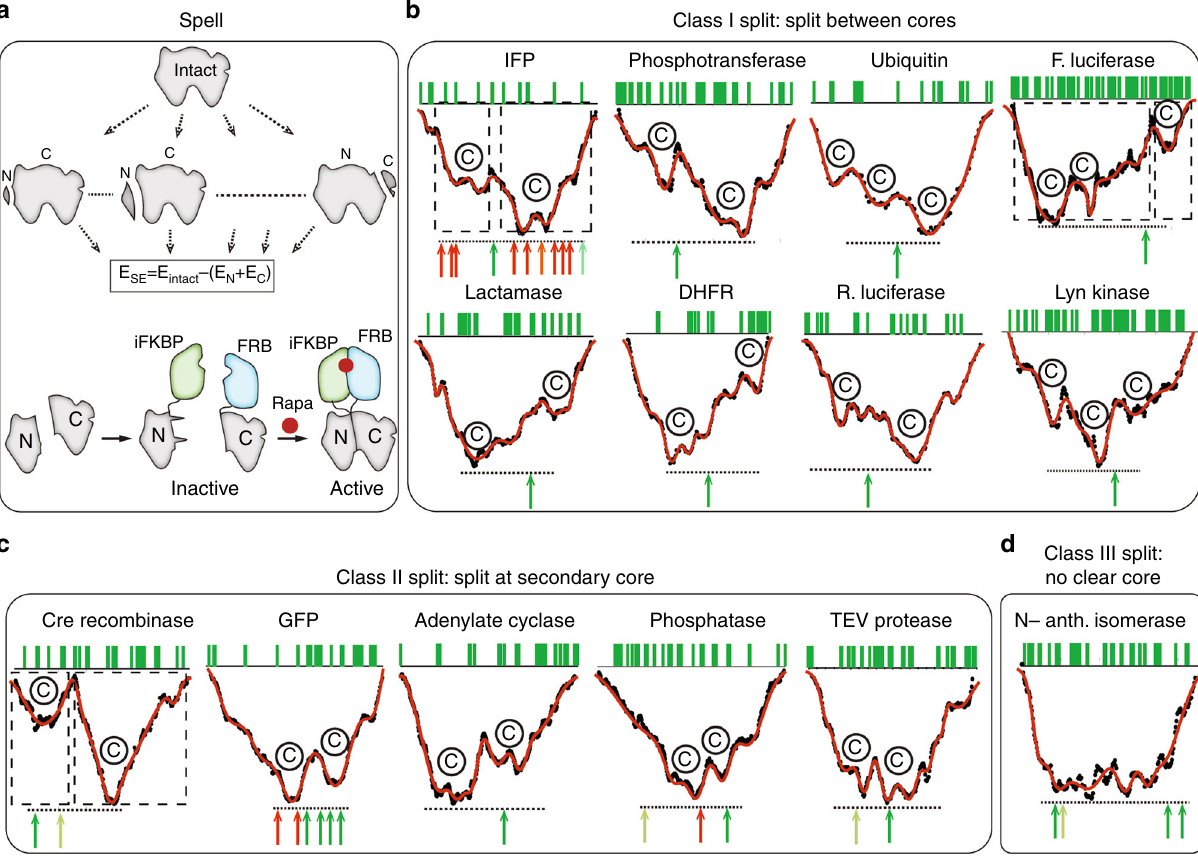
Fig. 1 The split energy and SPELL. a The target protein is computationally split, and the summed energy of the split parts (N and C lobes) are subtracted from the energy of the intact protein to calculate the split energy (SE). The split energy along with other fi lters, including solvent accessible area (SAA) and sequence conservation, were used to identify split sites. Prevention of spontaneous assembly is achieved using insertable FKBP (iFKBP), which destabilizes one of the lobes. Rapamycin or its photoactivatable analog produces both reassembly and correct folding of the destabilized lobe. b Proteins that have successful split sites between cores (labeled as “ C ” ). Arrows show split sites described in the literature. Green arrows were described as successful, red as unsuccessful. Dashed boxes indicate known domains. c Proteins that have successful split sites at a secondary core. d A protein that has no